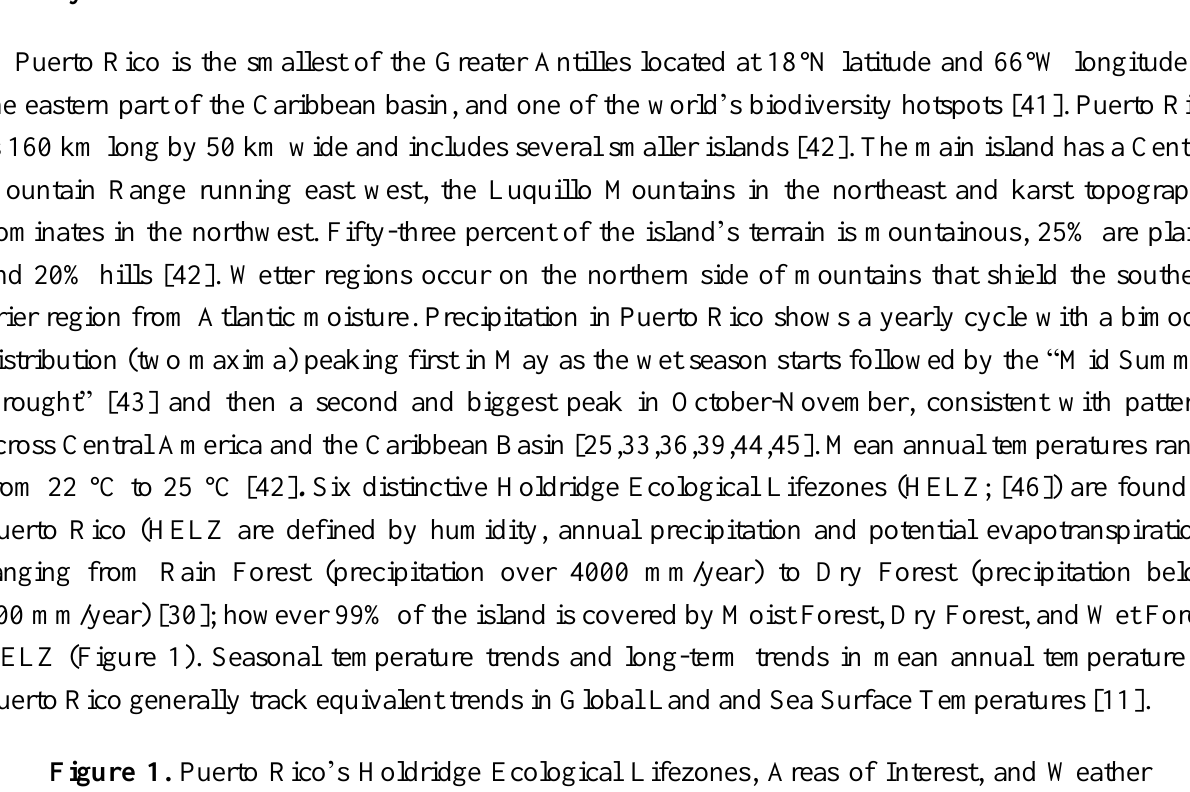
Figure 1. Puerto Rico’s Holdridge Ecological Lifezones, Areas of Interest, and Weather stations. HELZ data from US Forest Service, urban areas data from Puerto Rico GAP 2004, weather stations data from NOAA Historical Climate